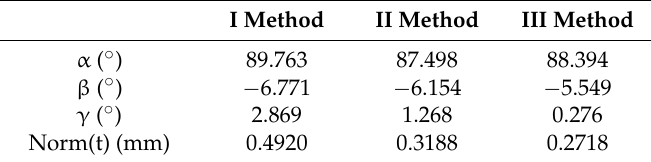
Table 1. Euler angles and norm of the translation vector for the three statistical methods.